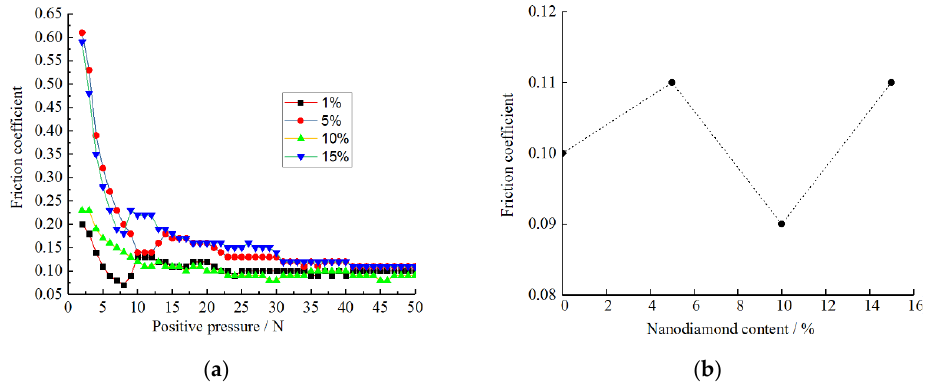
Figure 10. External load versus friction coefficient of the composite coating: ( a ) trend of the outermost load of the friction coefficient and ( b ) relationship between nanodiamond content and friction coefficient of the composite coating.